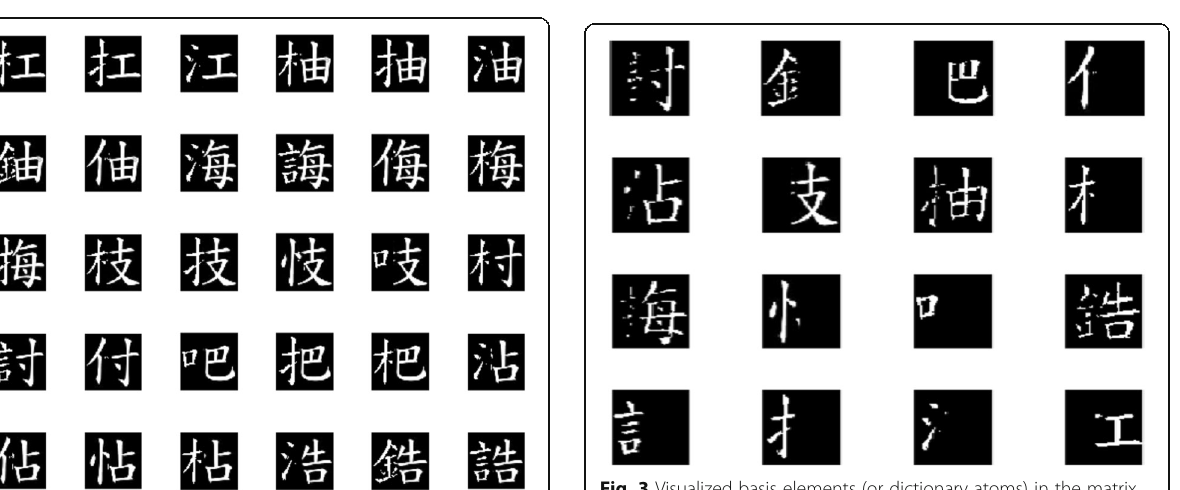
Fig. 3 Visualized basis elements (or dictionary atoms) in the matrix W , obtained by factorizing the matrix V , formed by the Chinese characters displayed in Fig.